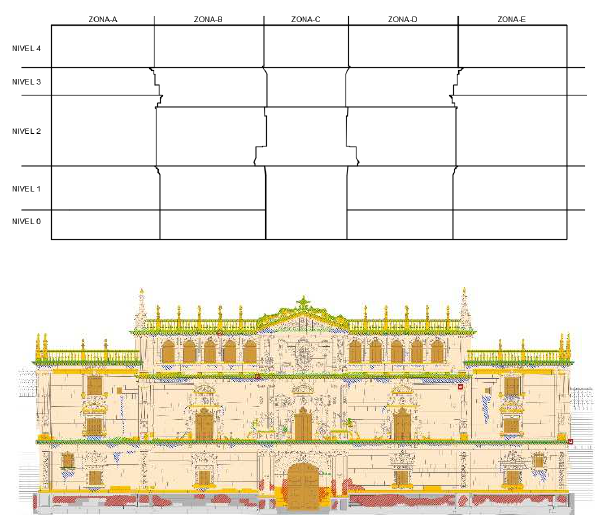
Figure 10: Location of scanner position and view of facade